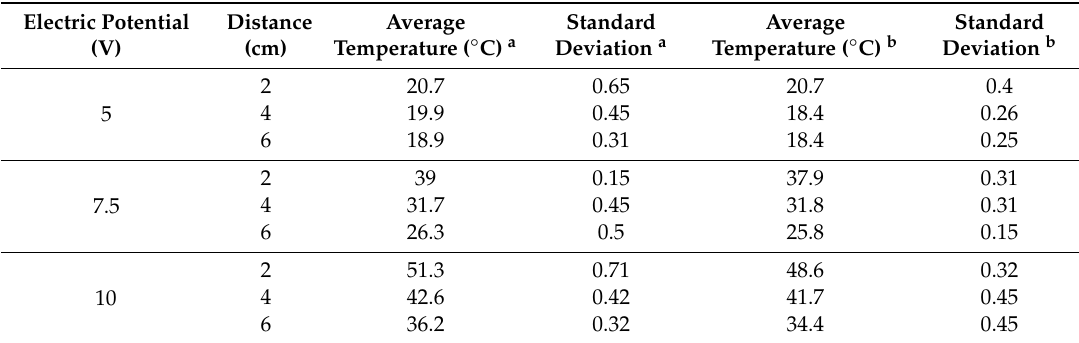
Table 4. Infrared thermography of EM4 with random and aligned fibers containing 1% TrGO recorded at di ff erent electric potentials and